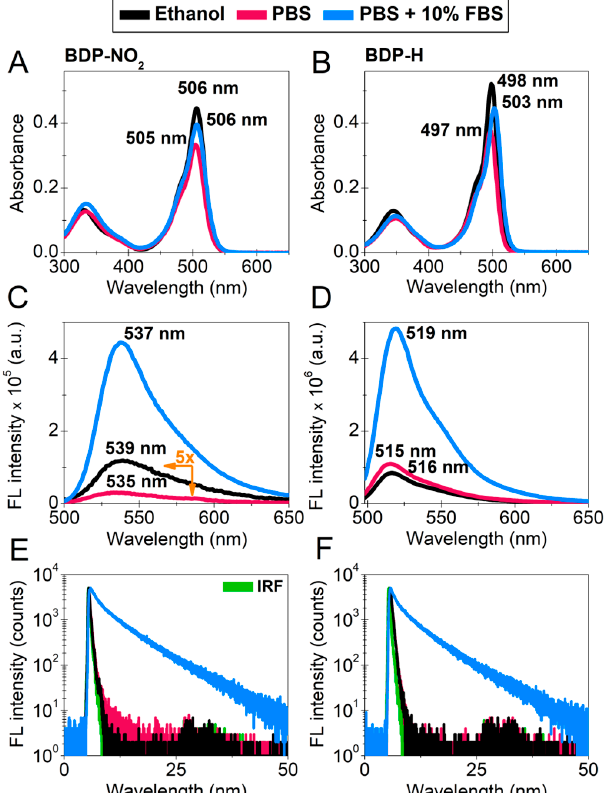
Figure 2. Photophysical characterization of BDP-NO 2 and BDP-H diluted in ethanol (black), PBS (red) or PBS + 10% FBS (blue). ( A , B ) absorption spectra. ( C , D ) fluorescence (FL) spectra under the same quantity of the absorbed light quanta, λ ex = 488 nm. ( E , F ) comparison of time-resolved FL decays, λ ex = 473 nm. IRF—instrument response function (green). Normalized absorption and FL spectra of both molecular rotors are displayed in Supplementary Materials Figure S1. Fitting parameters of the FL decays are displayed in Supplementary Materials Table